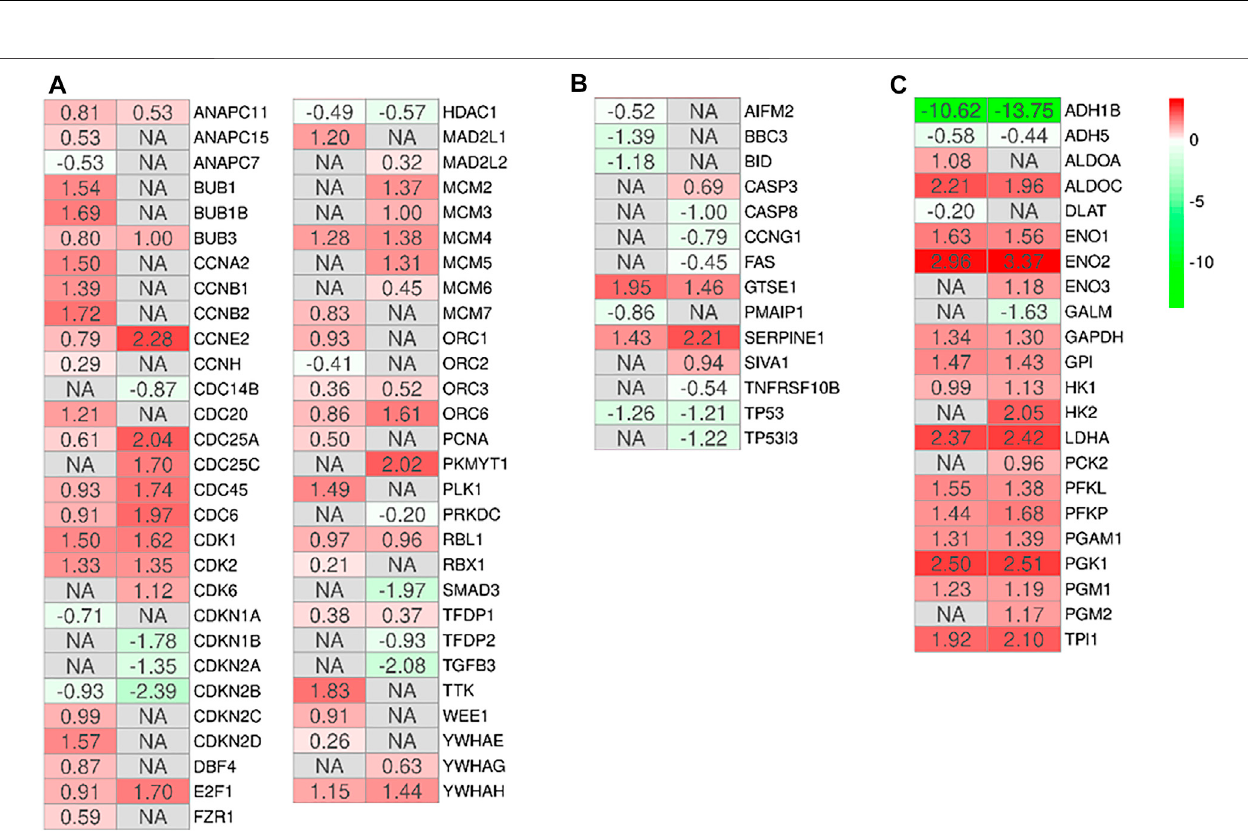
FIGURE 3 | Heatmap of genes involved in the activation of the cell cycle (A) , inhibition of the apoptosis (B) or activation of the cellular metabolism (C) in the comparison of MSCs-lung-Normoxia against MSCs-lung-Hypoxia or MSCs-CPAM-Normoxia (left column of each comparison) against MSCs-CPAM-Hypoxia (right column of each comparison). The green scale is related to downregulated genes whereas the red palette represents upregulated ones. NA value is put when the difference is not statistically relevant in the comparison. All fold changes are rounded to the second decimal digit.